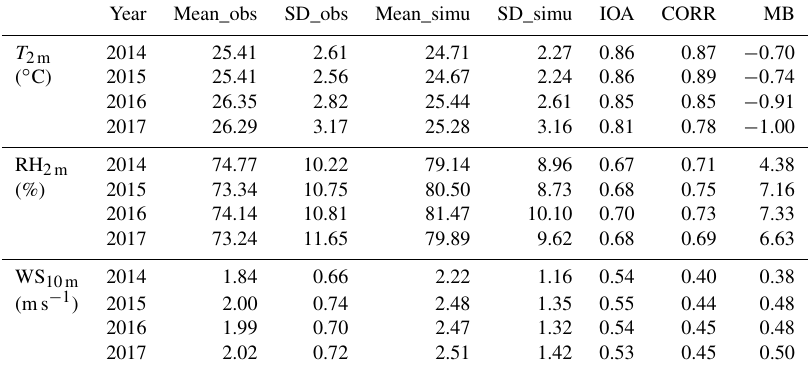
Table 3. Evaluation results for the temperature at 2m ( T 2m ), relative humidity at 2m (RH 2m ), and wind speed at 10m (WS 10m ) for different years in China. Mean_obs (Mean_simu) is the mean value of observation (model simulation); SD_obs (SD_simu) is the standard deviation of the observation (model simulation); IOA is the index of agreement; CORR is the correlation coefficient; MB is the mean bias.